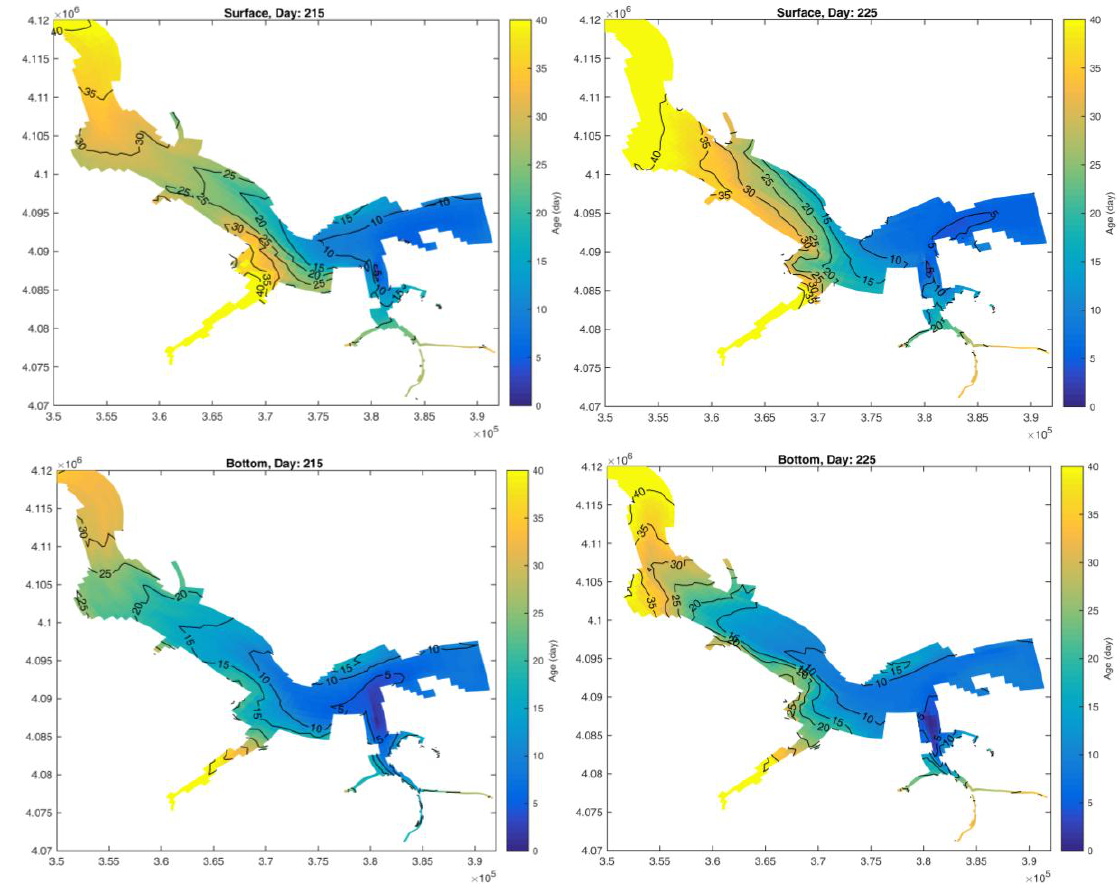
Figure 15. Travel time (age) corresponding to the dissolved substances released from the mouth of the Elizabeth River at Day 215 ( left , spring tide) and Day 220 ( right , neap tide). The travel time is relative to the releasing day.